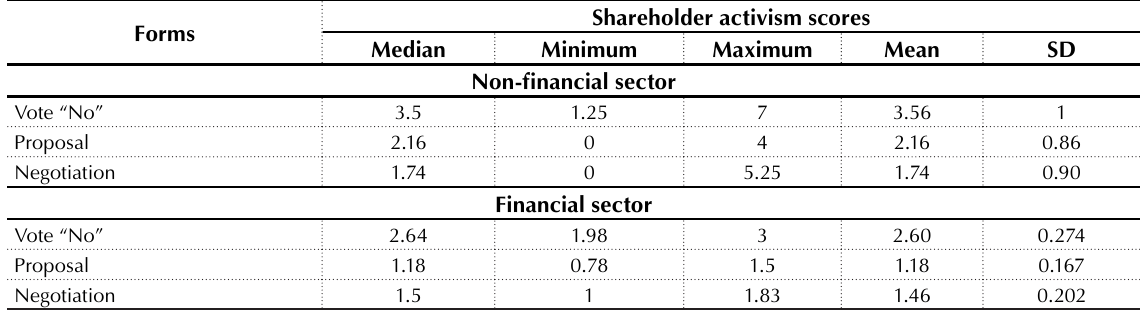
Table 3. The average annual shareholder activism scores among listed financial and non-financial companies